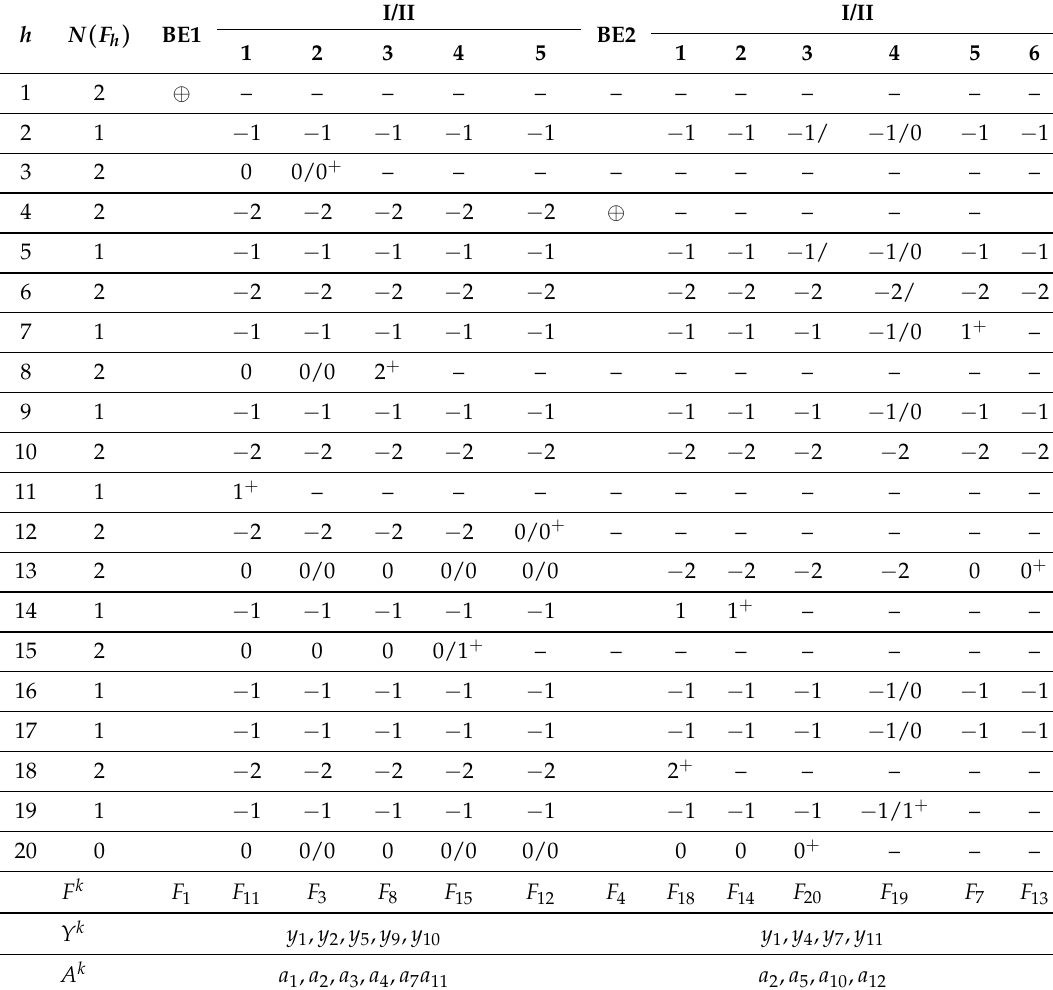
Table 3. The constructing the partition Π F